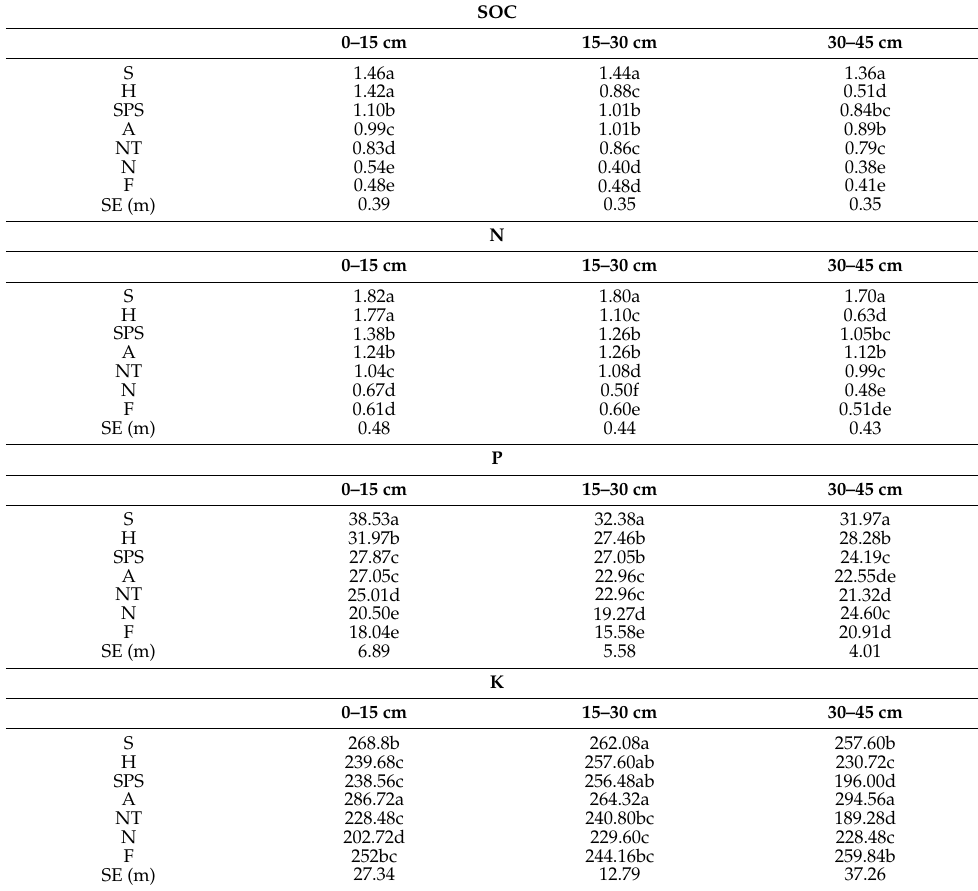
Figure 1. Bulk density (g cc − 3 ) in surface (0–15 cm) and subsurface (15–30 cm and 30–45 cm) soil layers, as influenced by different LUS in semi-arid environment. Error bars indicate LSD at p < 0.05. See Materials and Methods for detailed information on LUS. D1: 0–15 cm, D2: 15–30 cm, and D3: 30–45 cm soil layers. Table 3. Total soil organic carbon (SOC; g kg − 1 ), available nitrogen (N; g kg − 1 ), phosphorus (P; kg ha − 1 ), and potassium (K; kg ha − 1 ) in surface (0–15 cm) and subsurface (15–30 cm and 30–45 cm) soil layers, as influenced by different LUS in semi-arid environment. Means with similar lowercase letters within a column are not significantly different at p < 0.05 according to LSD test. See Materials and Methods for detailed information on a similar TOC in all soil layers (Table 3).